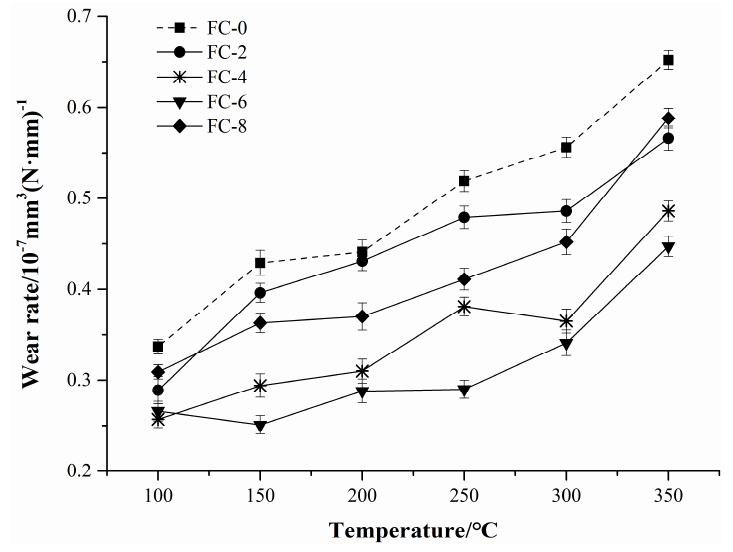
Figure 5. Wear rates of the friction specimens.